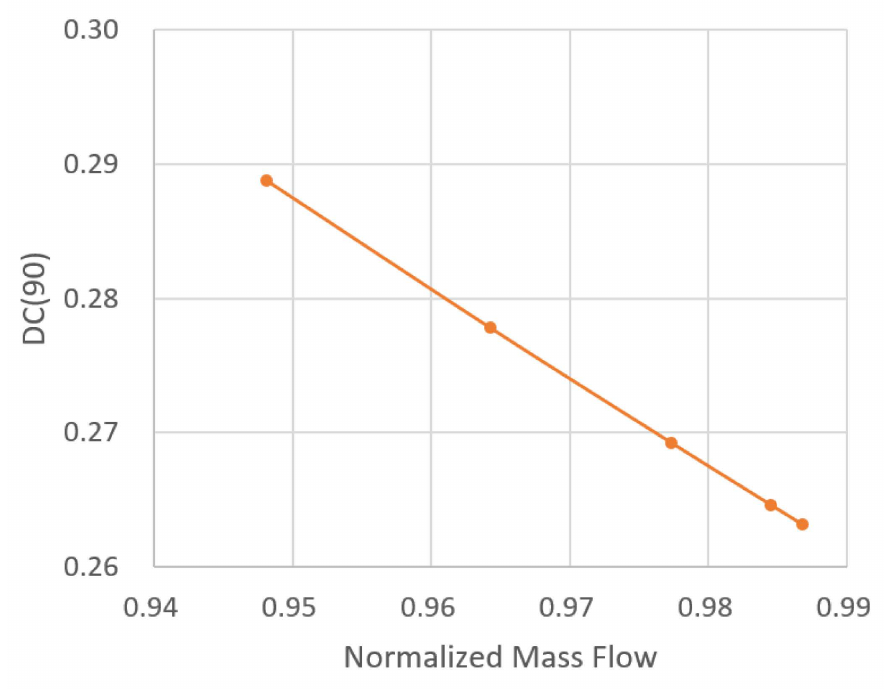
Figure 14. DC ( 90 ) vs. inlet mass